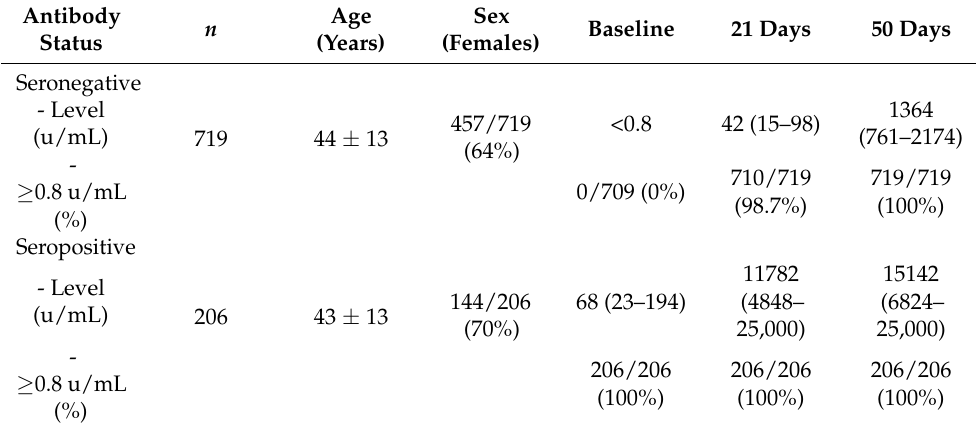
Table 1. Total anti-SARS-CoV-2 RBD antibodies levels (median and interquartile range) in